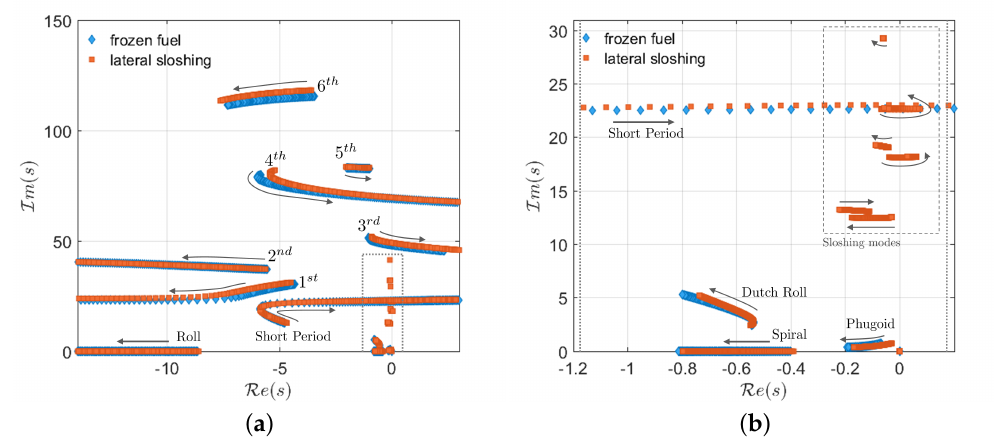
Figure 11. Root locus with linear sloshing—Test Case 2. ( a ) Root locus of the integrated system. ( b ) Focus on the rigid body and sloshing